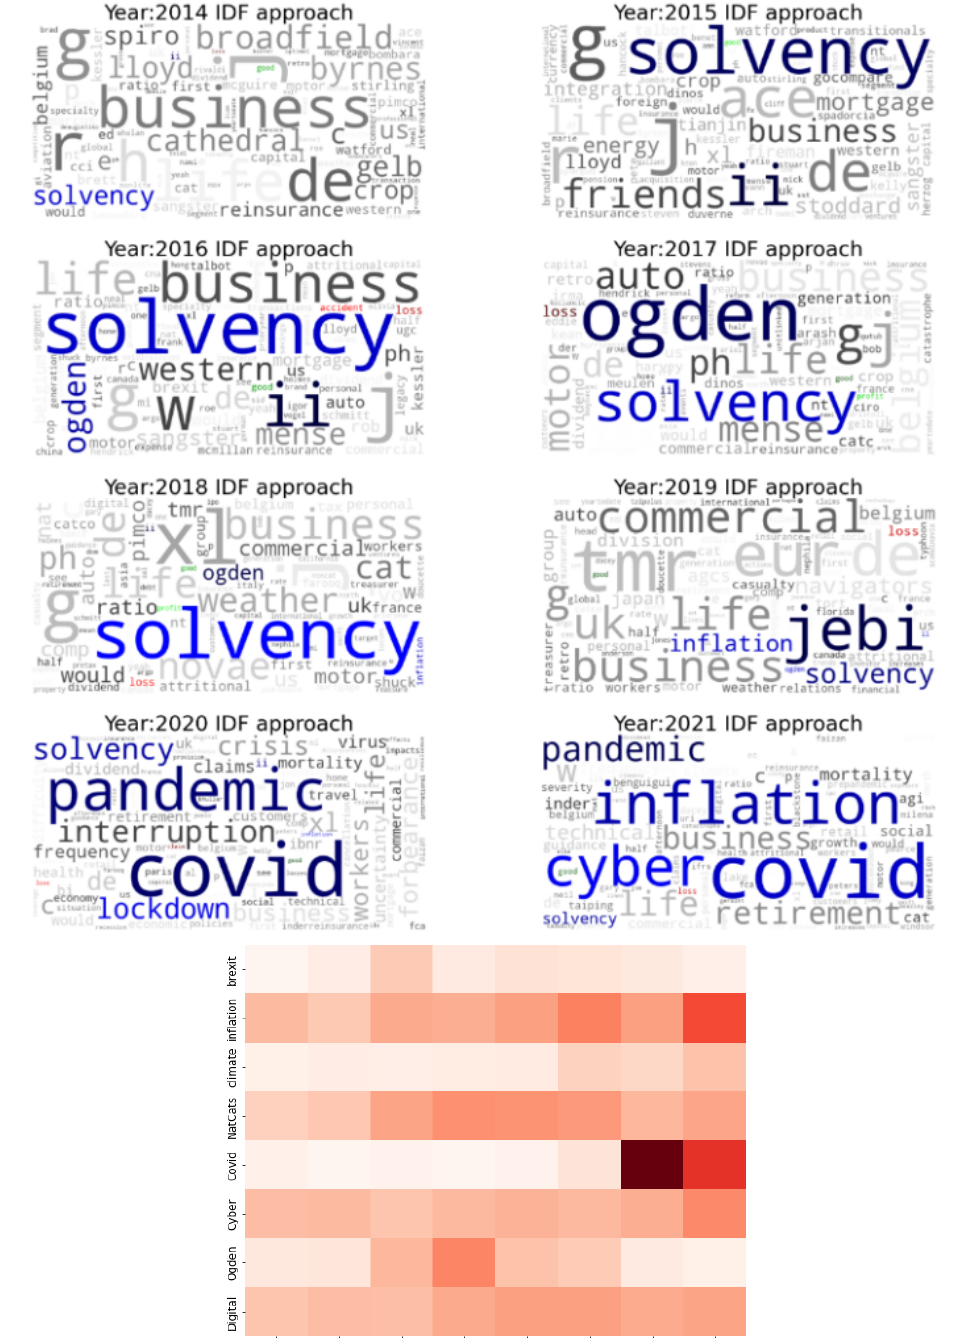
Figure 3. Top : Uni-gram word clouds for the period 2014–2021. Each cloud represents all IDTs in one year. Note: words are coloured according to their polarity—green positive, red negative, grey neutral. Words in blue highlight those selected for comment. Bottom : Uni-gram word heat map of TF-IDF scores over each year, from 2014 to